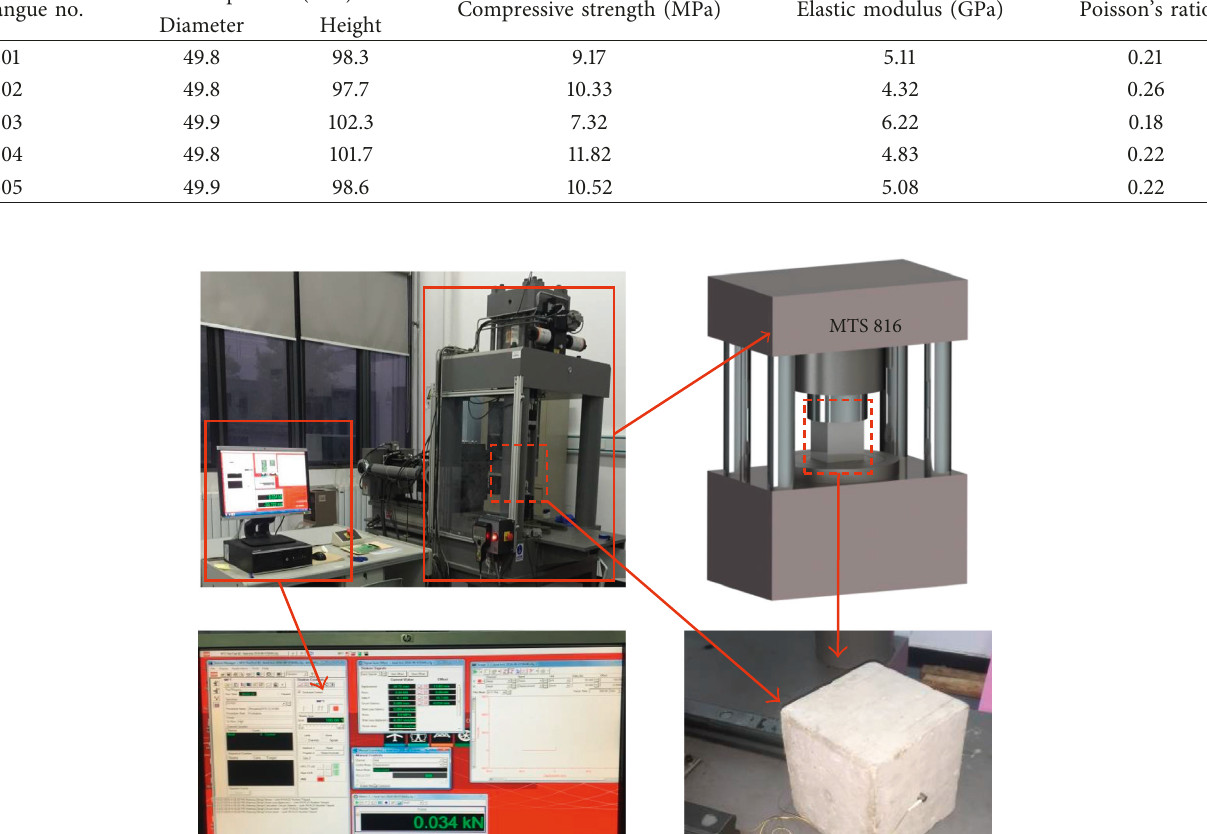
Table 1: Unconfined uniaxial compression test results for the standard cylindrical gangue samples. Gangue no.